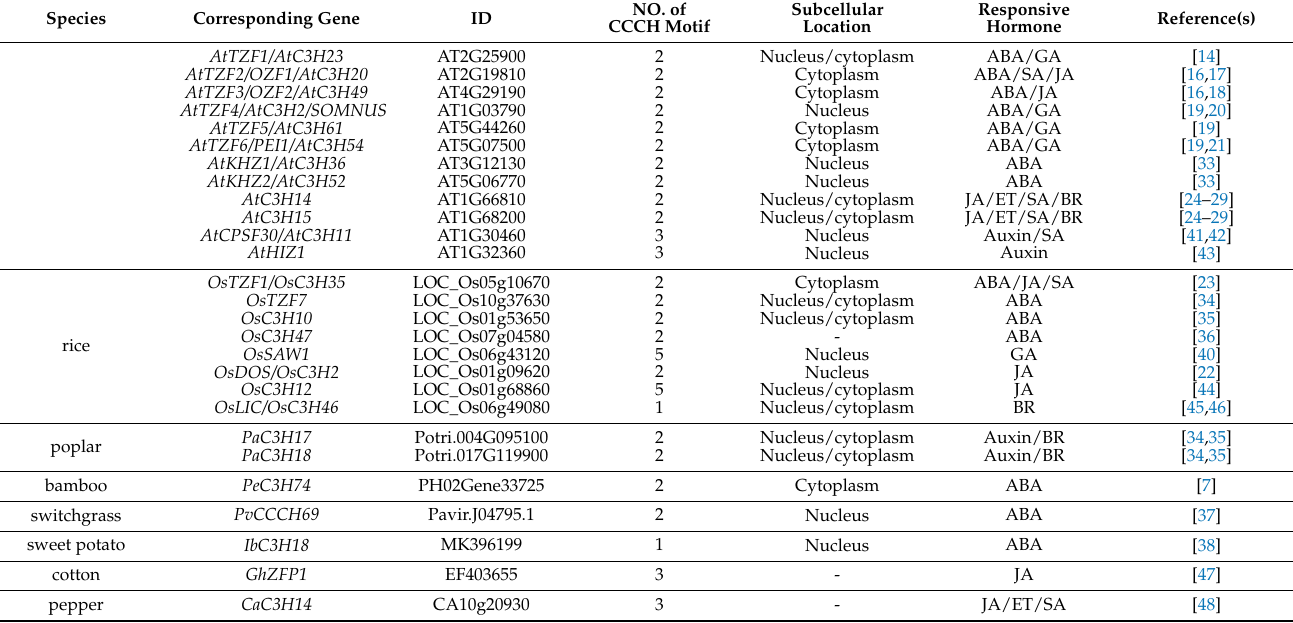
Table 1. CharacteristicsofCCCHproteinswithknownfunctionsandtheirresponsestodifferenthormones.